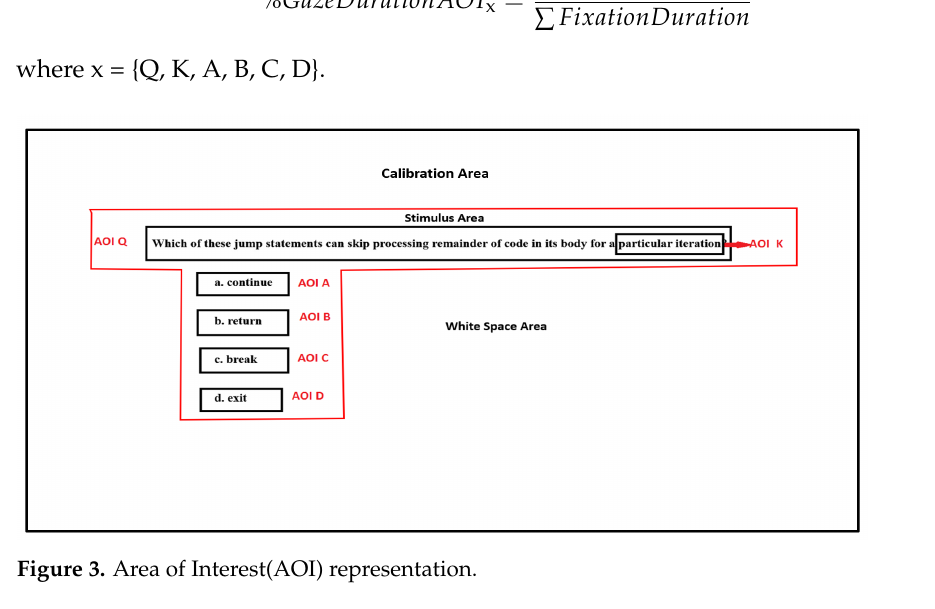
Figure 3. Area of Interest(AOI) representation.